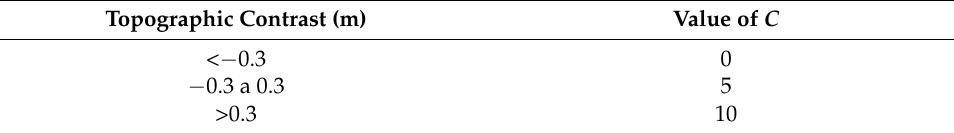
Figure 3. Illustration of topographic contrast and identification by comparing detailed and smoothed digital elevation models (DEMs). Table 2. Criterion for selecting the value of C in Equation (1). Topographic Contrast (m)